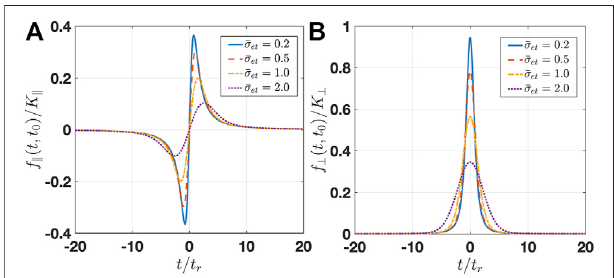
FIGURE 2 | The weighed interaction strength f ( t , t 0 ) for (A) M i , j , (cid:4) ( z ) and (B) M i , j , ⊥ ( z )